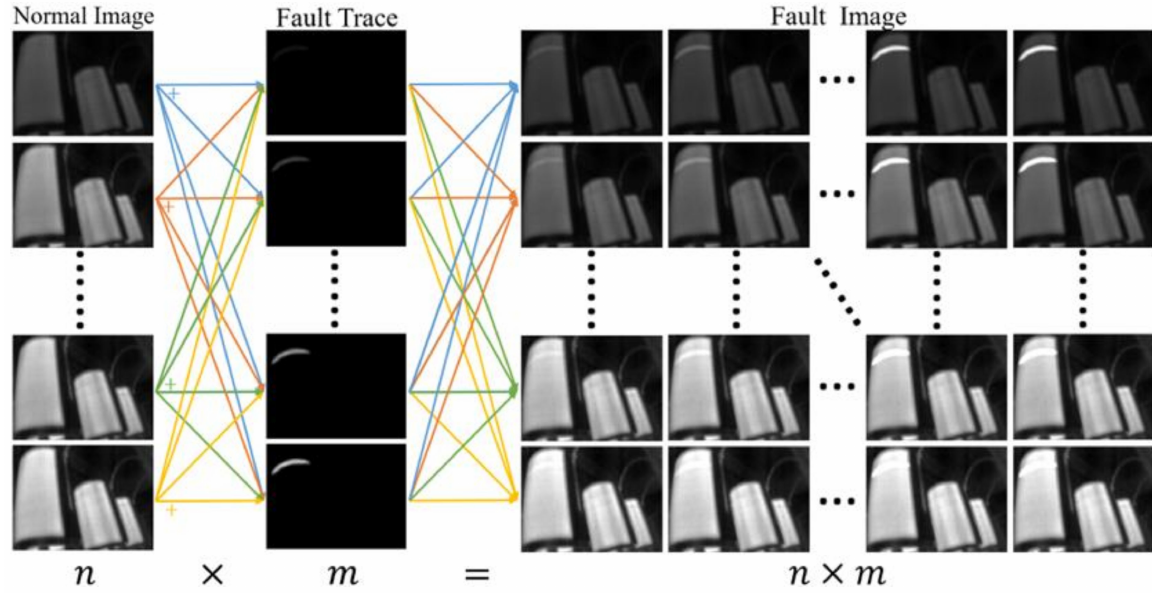
Figure 11. The total thermal imaging established by a fault type. (One fault trace image, s =